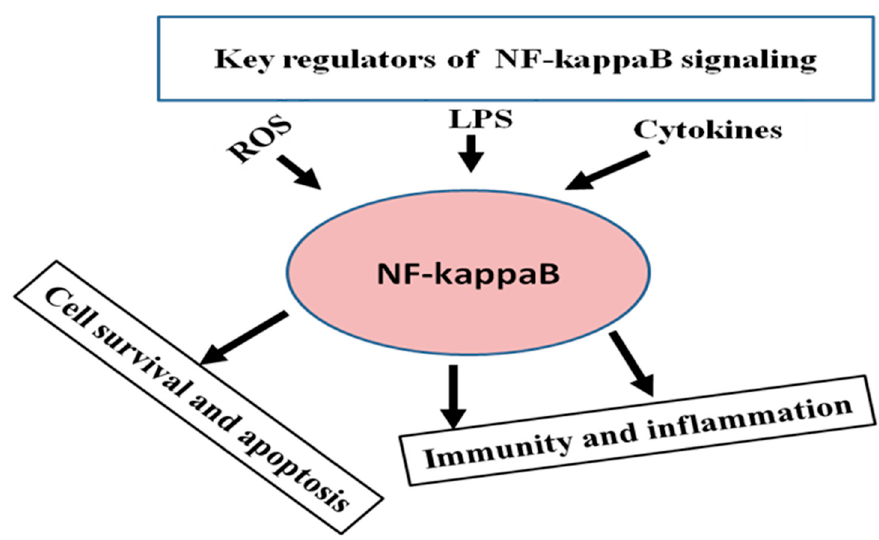
Figure 1. The key inducers of the NF- κ B pathway and regulation of immunity, inflammation, cell survival and apoptosis by NF- κ B signaling.